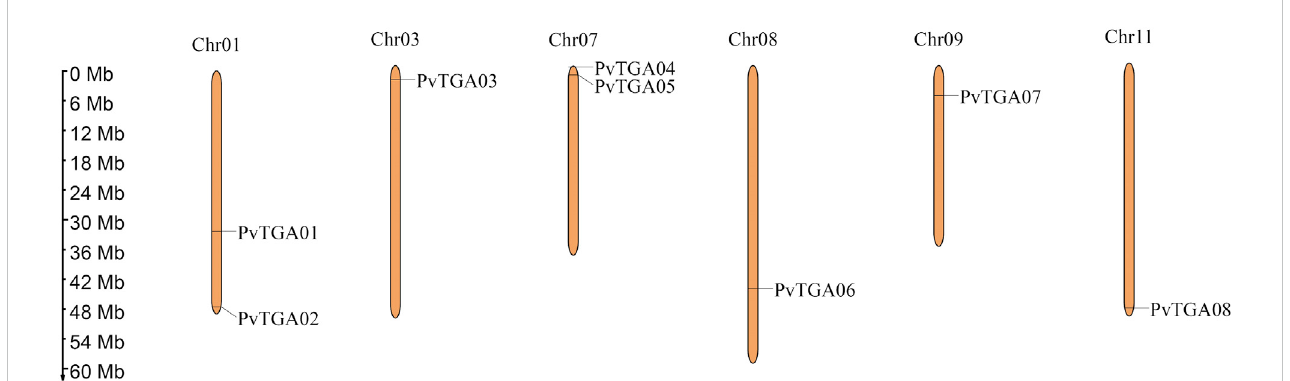
FIGURE 1 Distribution of TGA genes on P. vulgaris chromosome. Chromosome size is indicated by its length. The scale on the left is shown in megabases (Mb).